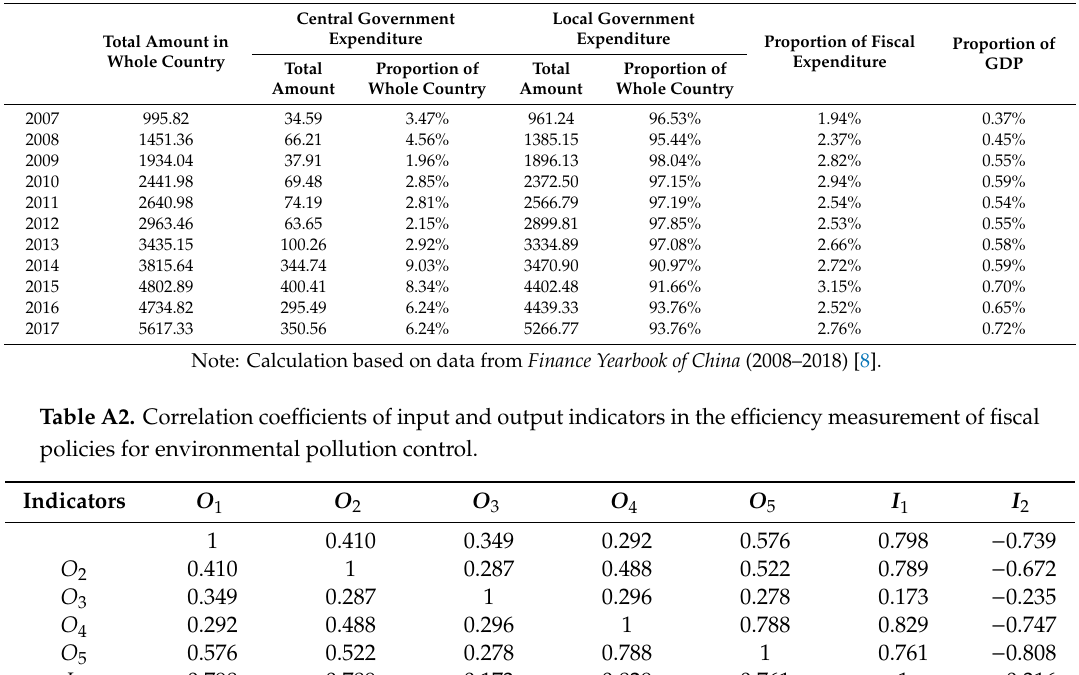
Table A1. The amount (10 8 CNY) and proportion (%) of the fiscal expenditure on environmental protection in China (2007–2017).